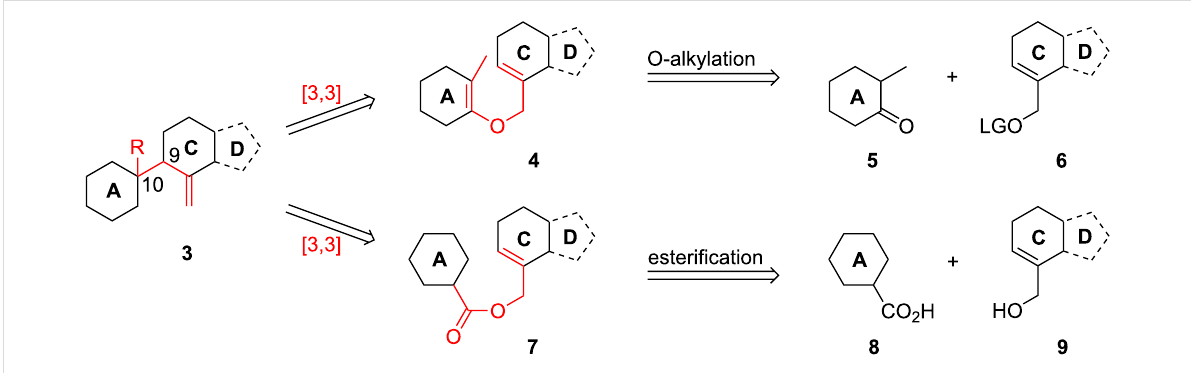
Scheme 1: Retrosynthetic analysis of the B- seco limonoid framework employing a [3,3]-sigmatropic rearrangement for formation of the C9–C10 bond. R = Me or CO 2 H, LG = leaving